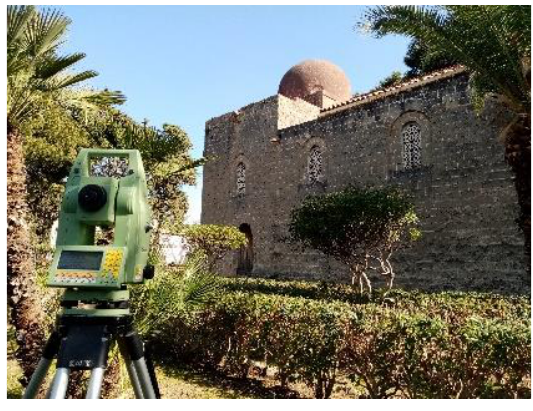
Figure 5. The topographic